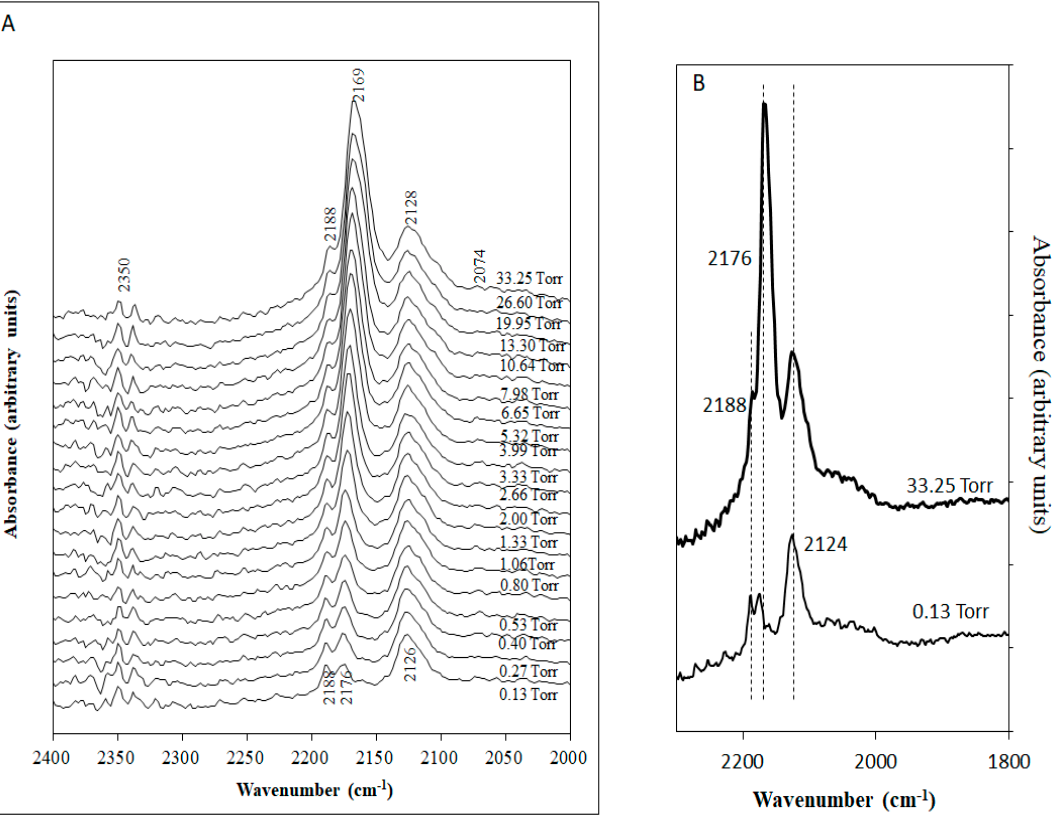
Figure 7. ( A ) FT-IR spectra of CO adsorbed on Rh / CeO 2 at 90 K. Indicated pressure is real working pressure. ( B ) Spectra obtained at the first (0.13 Torr) and at the last (33.25 Torr) CO exposure.